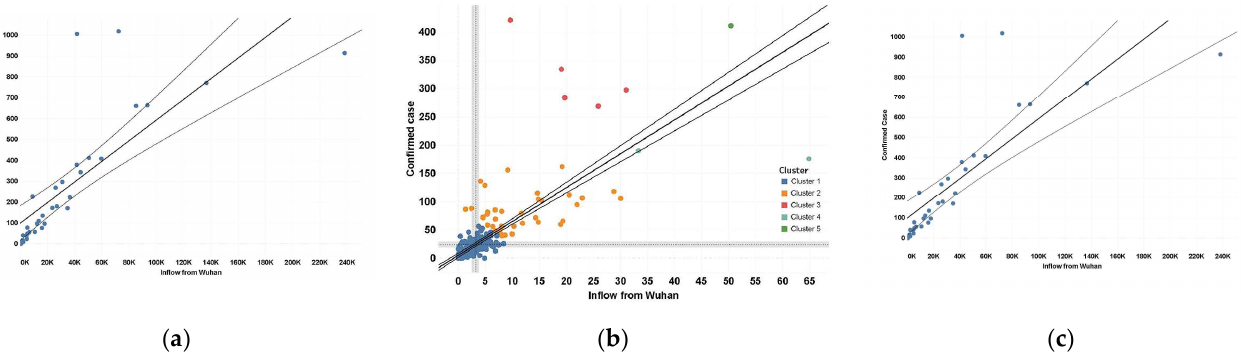
Figure 13. The correlation of the local confirmed cases and inflows from Wuhan (( a ) the results of provinces; ( b ) the results of cities outside Hubei; ( c ) the results of cities inside Hubei province).